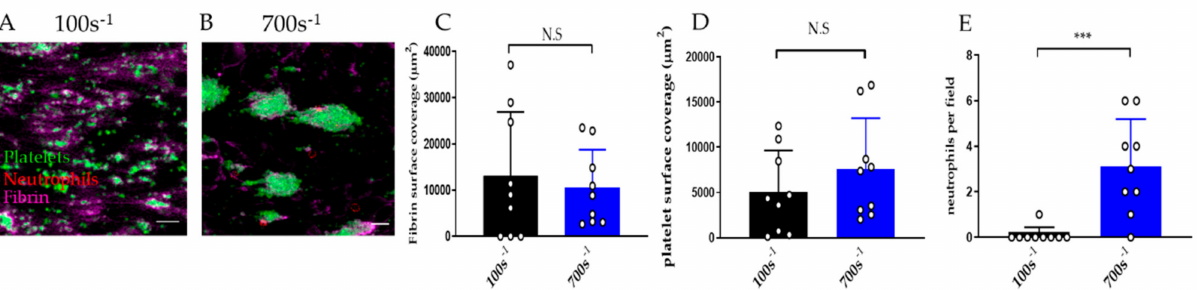
Figure 7. Effect of shear rate on performance of the thromboinflammation chip. Whole blood was perfused on endothe- lialised chips for 4 min at low (100 s − 1 ) and high (700 s − 1 ) shear. Representative images of fibrin (magenta), platelet (green), and neutrophil (red) adhesion on endothelialised chip after perfusion of recalcified citrated blood, at ( A ) low (100 s − 1 ) versus ( B ) high (700 s − 1 ) shear. ( C ) Fibrin and ( D ) platelet surface coverage and ( E ) neutrophils per 40 × field at 4 min after perfusion at 100 s − 1 (black columns) and 700 s − 1 shear (blue columns). Data is mean ± SD of nine fields of view from n = 3 separate donors. *** p < 0.001, N.S = non-significant by two-tailed, non-parametric t -test